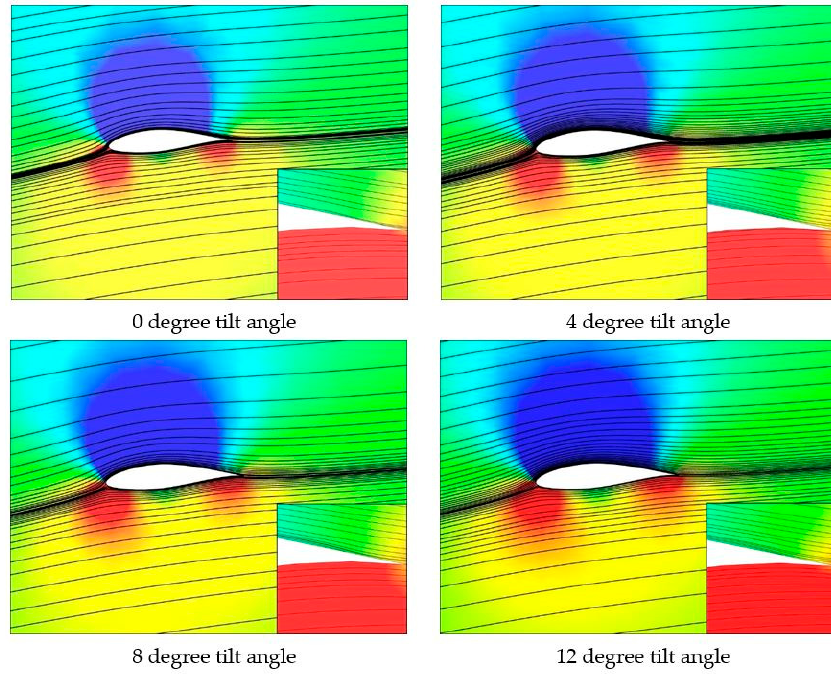
Figure 13. Instantaneous pressure magnitude and streamlines diagram (r / R = 0.7).